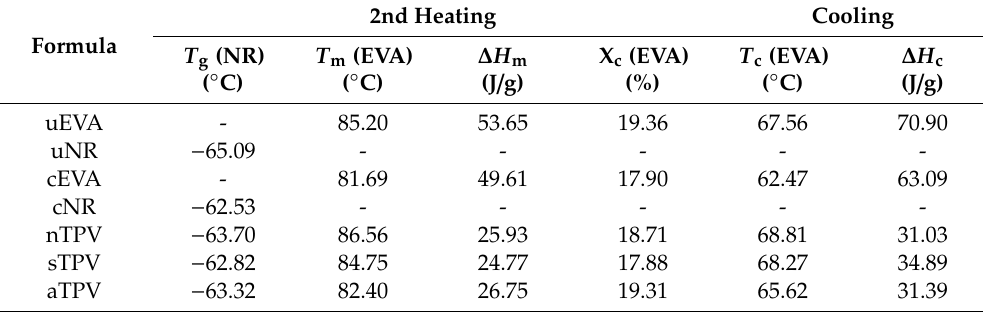
Figure 3. Differential scanning calorimetry (DSC) thermograms of uncured and cured EVA, NR, as well as EVA / NR TPVs: the second heating scan ( a ) and cooling scan ( b ) at heating/cooling rate of 10 °C/min. Table 2. Thermal properties of uncured and cured EVA, NR, as well as EVA / NR TPVs samples prepared with di ff erent